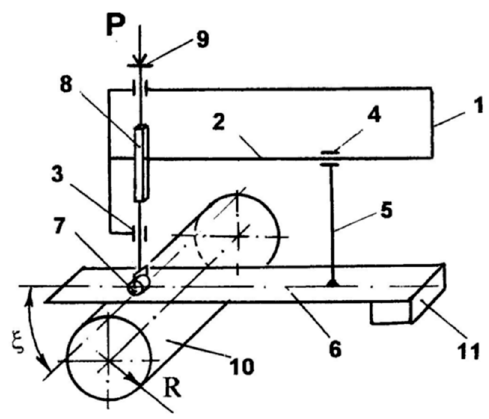
Figure 7. Kinematic scheme of device for the estimation of friction anisotropy on the cylindrical